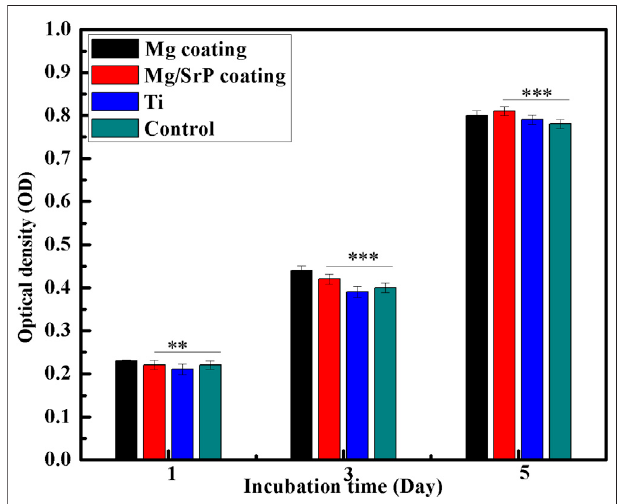
FIGURE 8 | Cell proliferation in extracts after 1, 3 and 5 days of incubation measured by CCK-8 assay. Statistically (n 3 (**) indicate, p < 0.01 while (***) indicate p < 0.03).